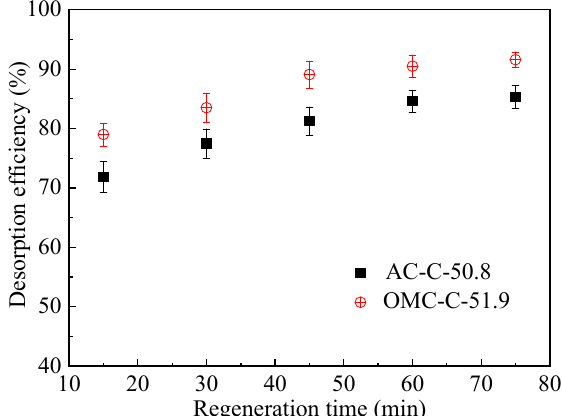
Figure 7. Desorption efficiency versus regeneration time for AC-C-50.8 and OMC-C-51.9 by water-washing regeneration method.